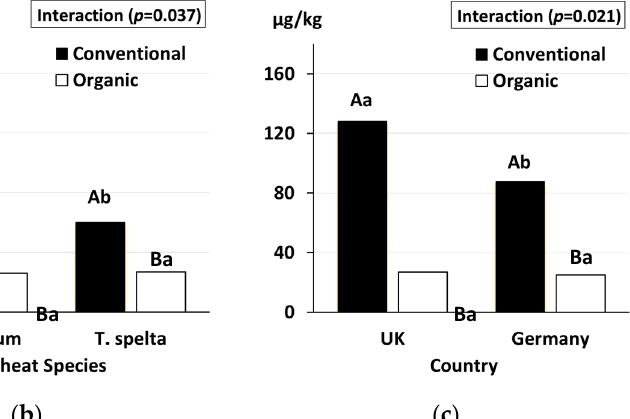
Figure 7. Effect of organic and conventional production methods on ( a ) the percent of samples testing positive for at least one pesticide residue. Data from [57], and ( b ) the number of different pesticide residues detected in fruits, vegetable and cereal-based foods. Data from [141]. #, cereals and cereal-based food products. ***, significant difference ( p < 0.001); **, significant difference ( p < 0.01); *, significant difference ( p < 0.05); T, trend (0.01 < p < 0.05); NS, not significant.